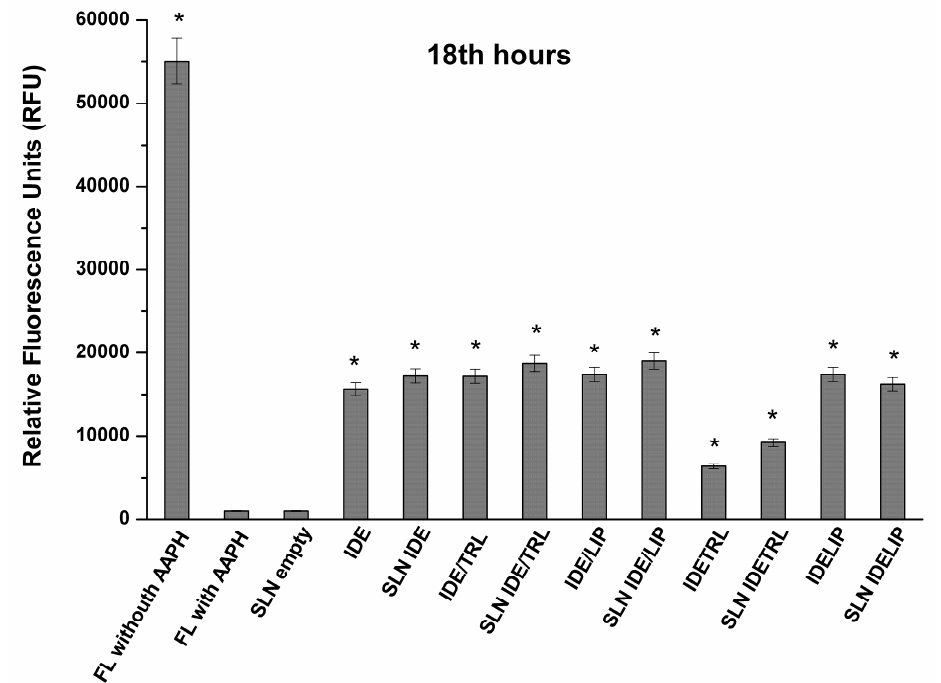
Figure 6. Antioxidant efficiency of IDE, IDETRL, IDELIP, and of the physical mixtures IDE/TRL and IDE/LIP, free or loaded into SLN, at the 18th hour. Data represent the mean of three independent experiments ± SD. * p < 0.05 with respect to positive control.